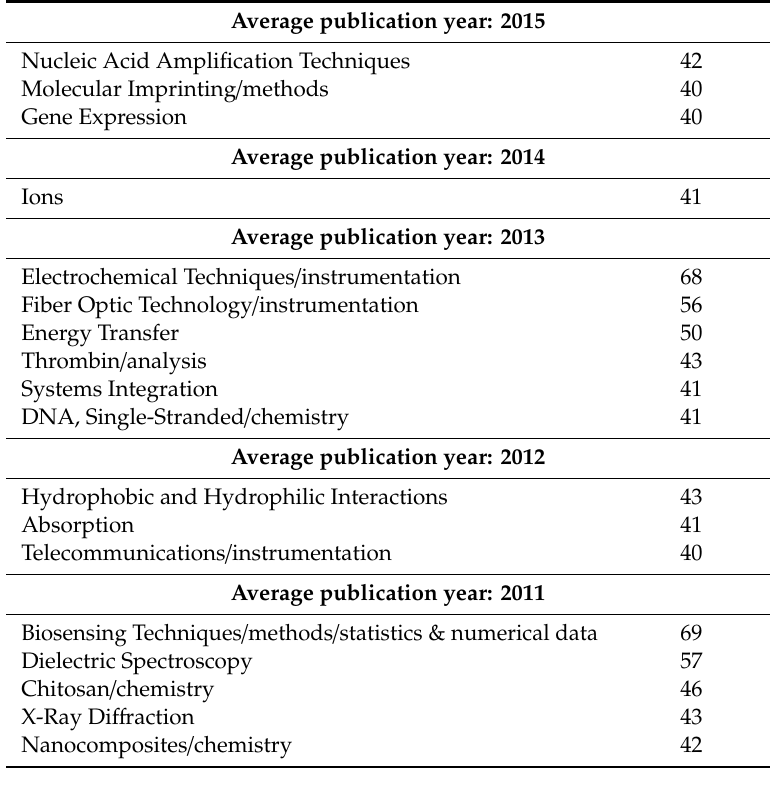
Table 10. Recent author keywords based on average publication years and the number of